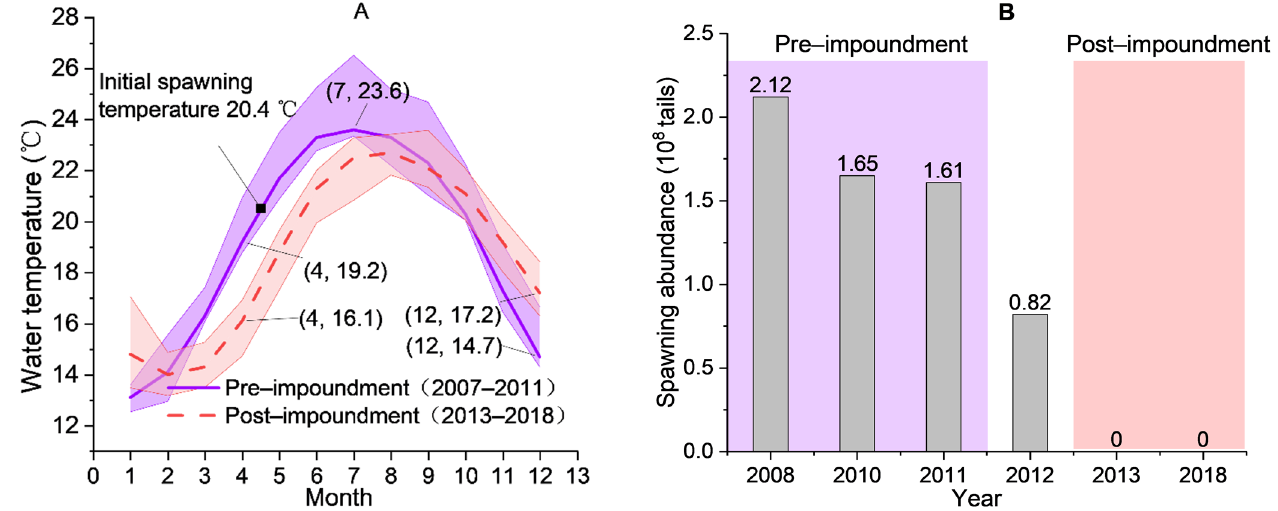
Figure A2. Water temperature and spawning abundance for pre- and post-impoundment. ( A ) The median line represented the average temperature, and shadows displayed the maximum and minimum range of temperature. ( B ) Spawning abundance of 2008, 2010–2013 [88] and spawning abundance of 2018 (this study).